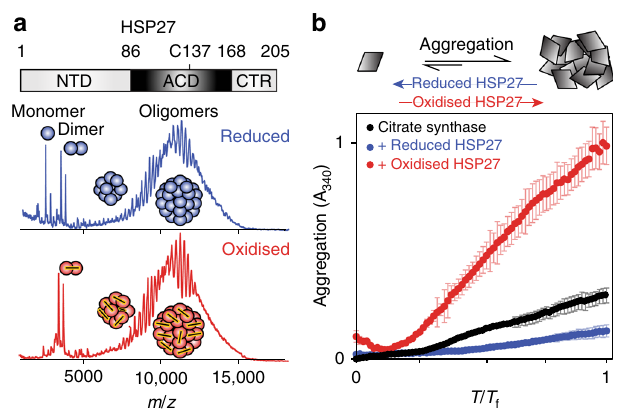
Fig. 1 Reduction of HSP27 releases highly active monomers. a Domain architecture of the human molecular chaperone HSP27, which forms polydisperse oligomers that reach >500 kDa. Native mass spectra collected at 25 μ M total monomer concentration for both oxidised (red) and reduced (blue, + 250 μ M dithiothreitol, DTT) HSP27 reveal the formation of polydisperse oligomers. More monomers are present in the reduced sample, although the oligomeric distributions are highly similar (Supplementary Fig. 1). b The chaperone activity of HSP27 was assayed by monitoring the increase in light scattering at 340 nm of 10 μ M of CS in the presence or absence of 0.5 μ M reduced (blue, 5 mM 2-mercaptoethanol, BME) or oxidised (red) HSP27. At this concentration, dimeric HSP27 comprises more than half of all populated stoichiometries. The average of two replicates is shown with error bars corresponding to ±1